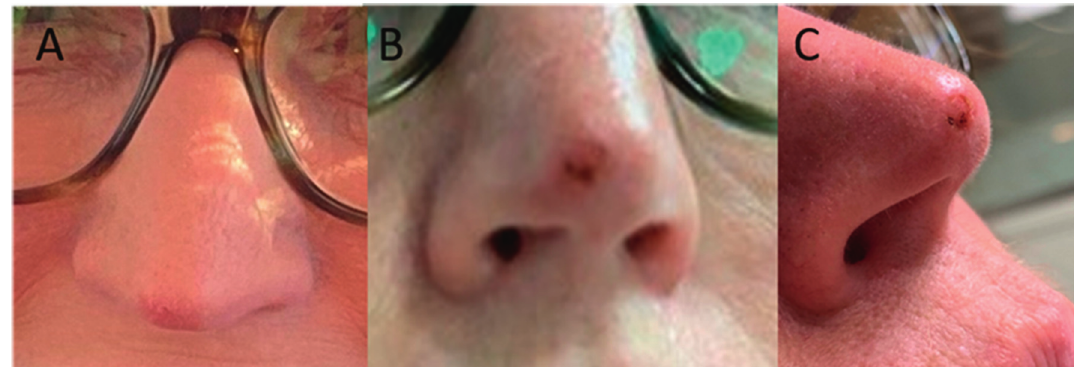
Figure 2: Three years later, the patient presented with a recurrent lesion on the nasal tip on 12/3/2019 (a) confirmed as recurrent BCC following a shave biopsy (b and c).